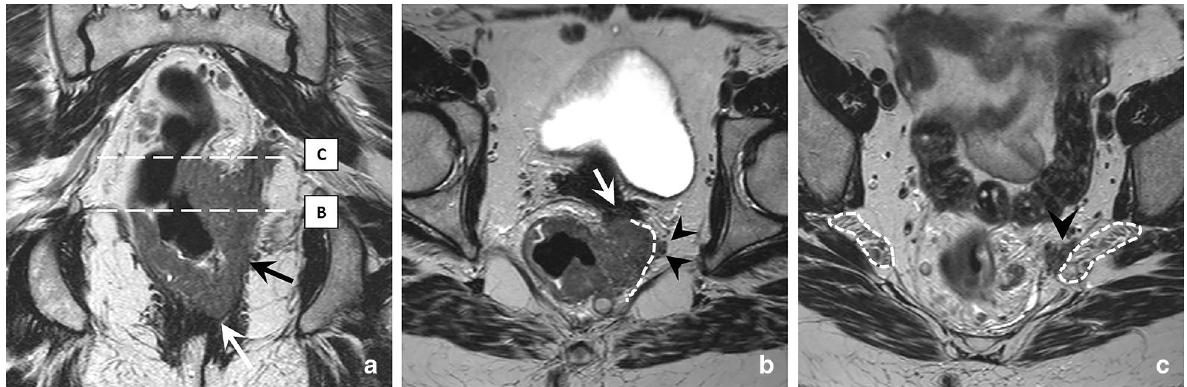
Fig. 9 Coronal T2‑weighted image ( a ) and axial T2‑weighted cross sections at two different levels ( b , c ) of a 48 year old female patient with a cT4b rectal tumour based on invasion of the left external anal sphincter (white arrow in a ; skeletal muscle invasion), invasion of the pelvic floor = (black arrow in a ; skeletal muscle invasion), invasion of the obturator compartment (arrowheads in b ; invasion of compartment outside the = = mesorectum), and invasion of the vagina (white arrow in b ; organ invasion). There is also a close relation to the sacral nerve plexus (white dotted = lines) on the left side (arrowhead in c